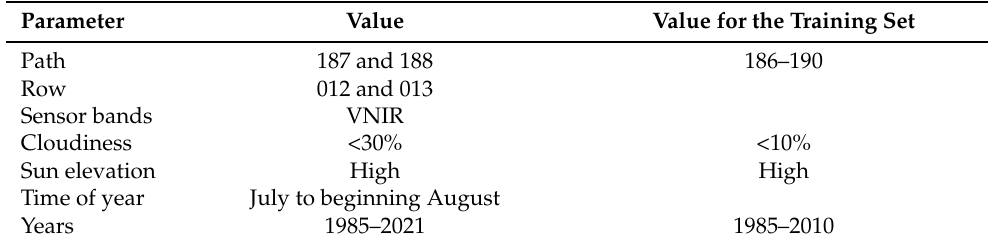
Table 1. Criteria for selecting Landsat images. Here, VNIR stands for visible and near-infrared portion of the electromagnetic spectrum and corresponding Landsat bands.